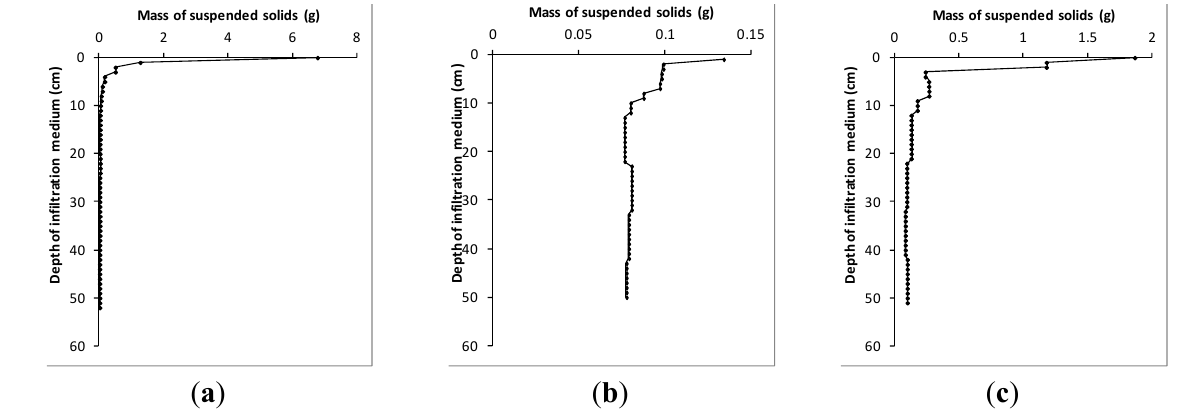
Figure 6. Deposition profile of suspended solids in column. ( a ) Surface clogging (Exp.